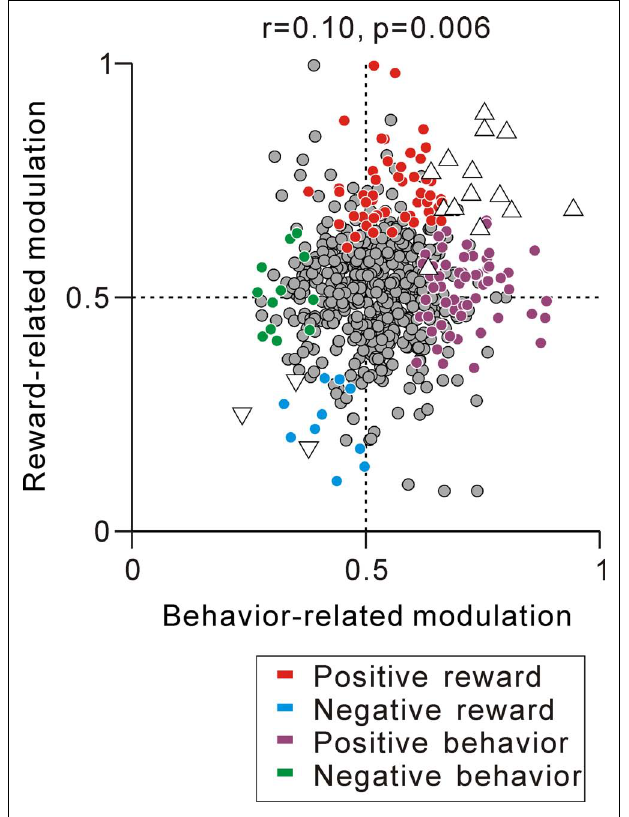
FIGURE 8 | Correlation between reward- and behavior-related modulation. A plot of behavior-related modulation ( x -axis) versus reward-related modulation ( y -axis) is shown. Behavior-related modulation was measured between its firing rates at 0–600 ms before the appearance of the initial stimulus for short versus long RTit trials. Reward-related modulation was measured between its firing rates at 0–600 ms after the onset of the reward-conditioned FT for large versus small reward trials.The marker colors indicate neurons showing positive reward modulation (red), negative reward modulation (cyan), positive behavioral modulation (purple), and negative behavioral modulation (green) ( p < 0.05).The white triangles indicate neurons showing correlated reward- and behavior-modulation by an increase (upward triangles) and decrease (downward triangles) in activity ( p <